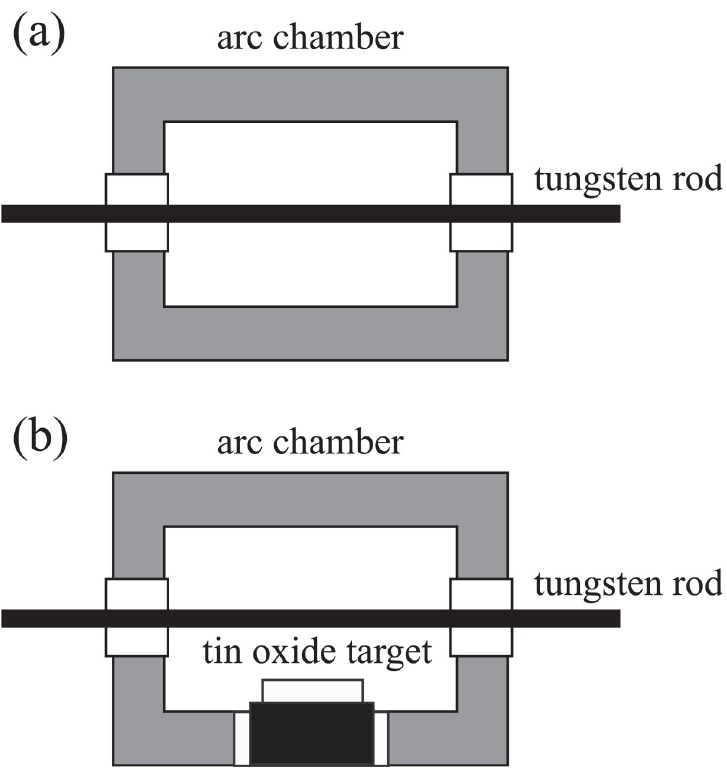
Fig 1. Schematic diagrams of (a) an ordinary Freeman-type ion source and (b) a modified Freeman-type ion source for a low-energy mass-selected ion beam machine.